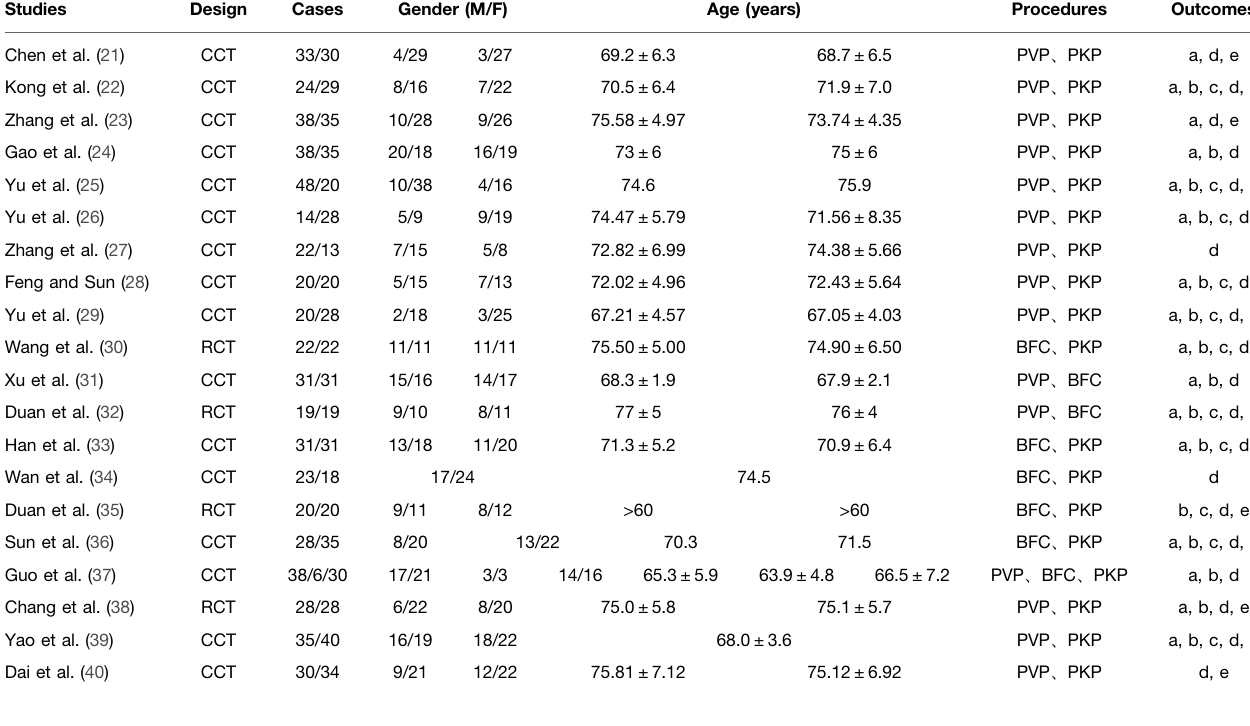
TABLE 1 | The characteristics of included